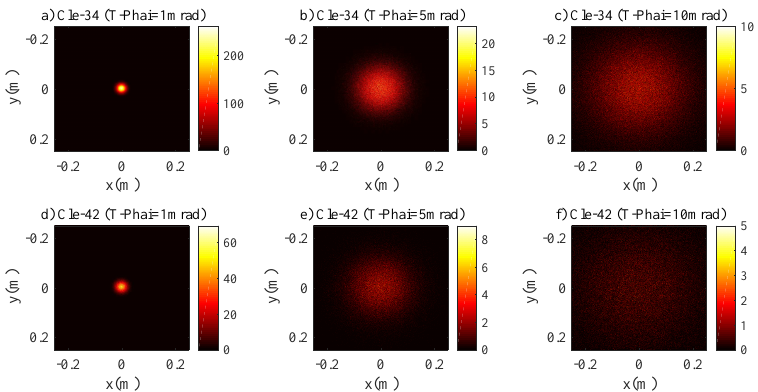
Figure 7. The 2D intensity distribution of the laser beam for the clean seawater channel ( a ) Cle-34 with T-Phai = 1 mrad, ( b ) Cle-34 with T-Phai = 5 mrad, ( c ) Cle-34 with T-Phai = 10 mrad, ( d ) Cle-42 with T-Phai = 1 mrad, ( e ) Cle-42 with T-Phai = 5 mrad and ( f ) Cle-42 with T-Phai = 10 mrad.